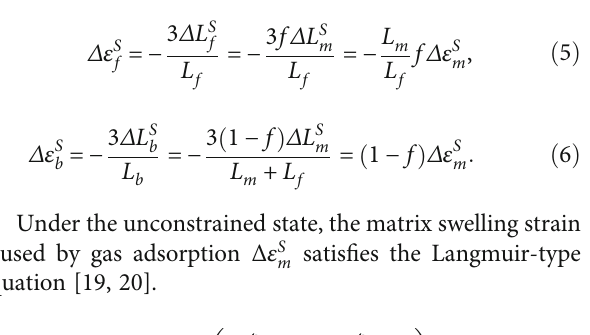
Figure 4: Schematic illustration of the saturation and triaxial